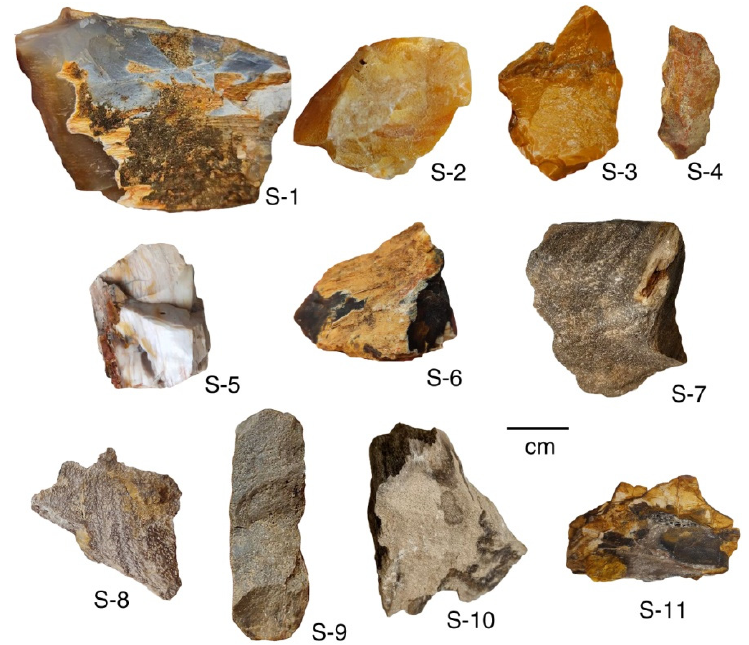
Figure 11. Khorat Plateau fossil wood specimens used for this study, showing specimen numbers. Samples are from Nakhon Ratchasima Province, except S-8, which is from Kohn Kaen Province. Table 2. Density and mineral composition of fossil wood specimens from locations in Nakhon Ratchasima Province.